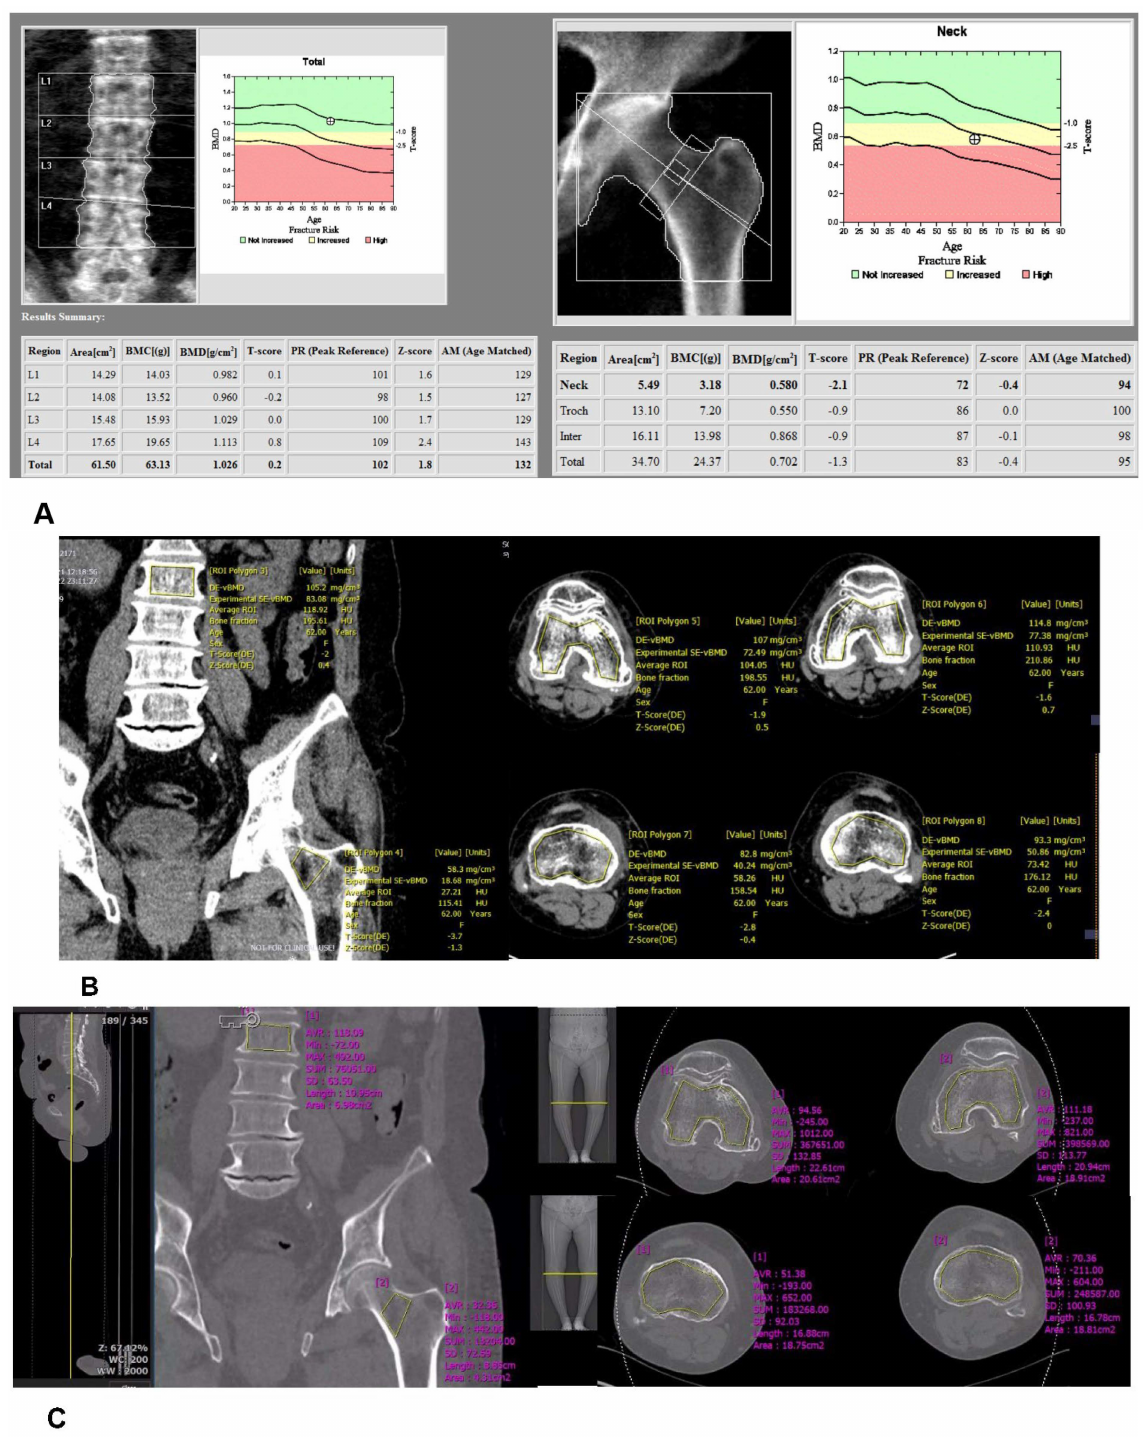
Figure 2. ( A ) Assessment of dual x-ray absorptiometry (DXA) in the lumbar spine and femur neck; ( B ) Manual definition of the region of interest (ROI) and assessment of bone mineral density (BMD) derived from dual-energy computed tomography (DECT) in the distal femur and proximal tibia using dedicated DECT postprocessing software; ( C ) Manual definition of the region of interest (ROI) and assessment of Hounsfield unit (HU) derived from dual-energy computed tomography (DECT) in the distal femur and proximal tibia using dedicated DECT postprocessing